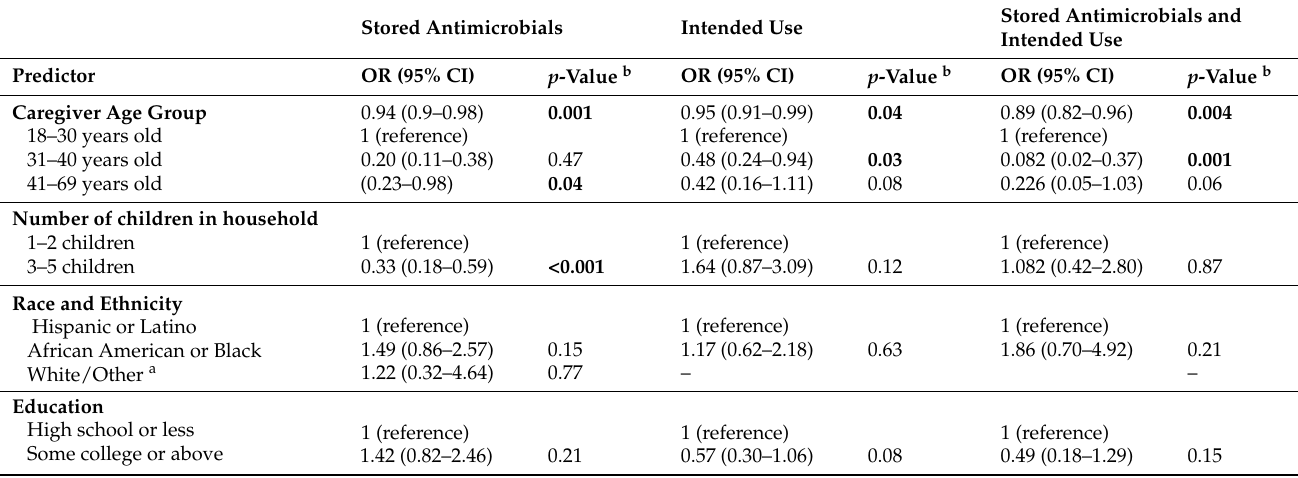
Table 2. Univariate logistic regression of predictors of stored antimicrobials and intended use of non-prescription antibiotics ( n =